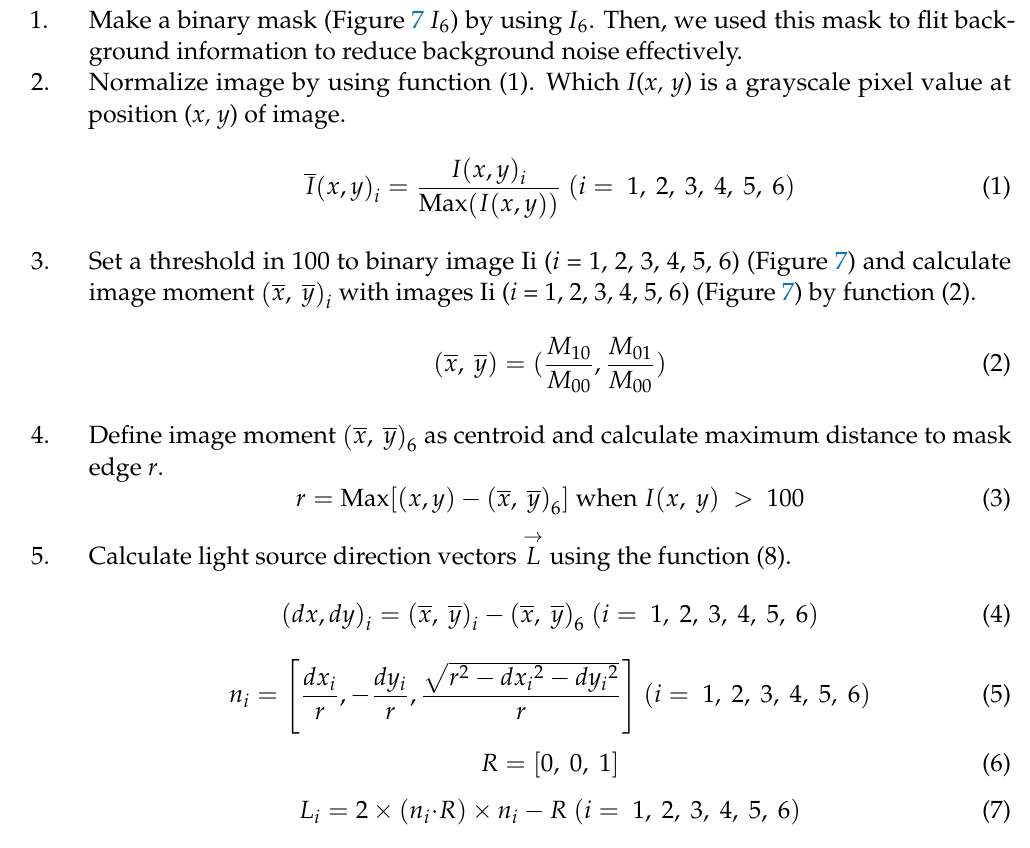
Figure 4. Schematic diagram of O-ring dimension.